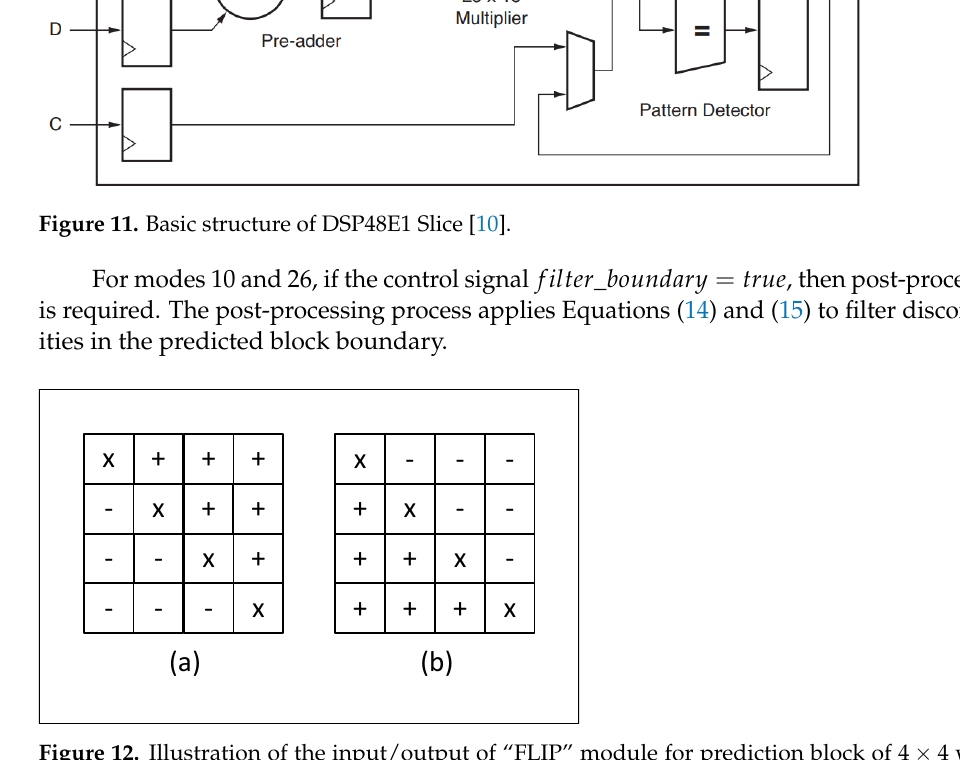
Figure 12. Illustration of the input/output of “FLIP” module for prediction block of 4 × 4 where: ( a ) input predicted block, ( b ) flipped block